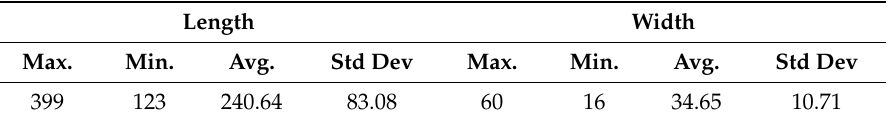
Table 2. Statistical evaluation of the lengths and widths of the ships in the dataset we use. Length Width Max. Min. Avg. Std Dev Max. Min. Avg. Std Dev 399 123 240.64 83.08 60 16 34.65